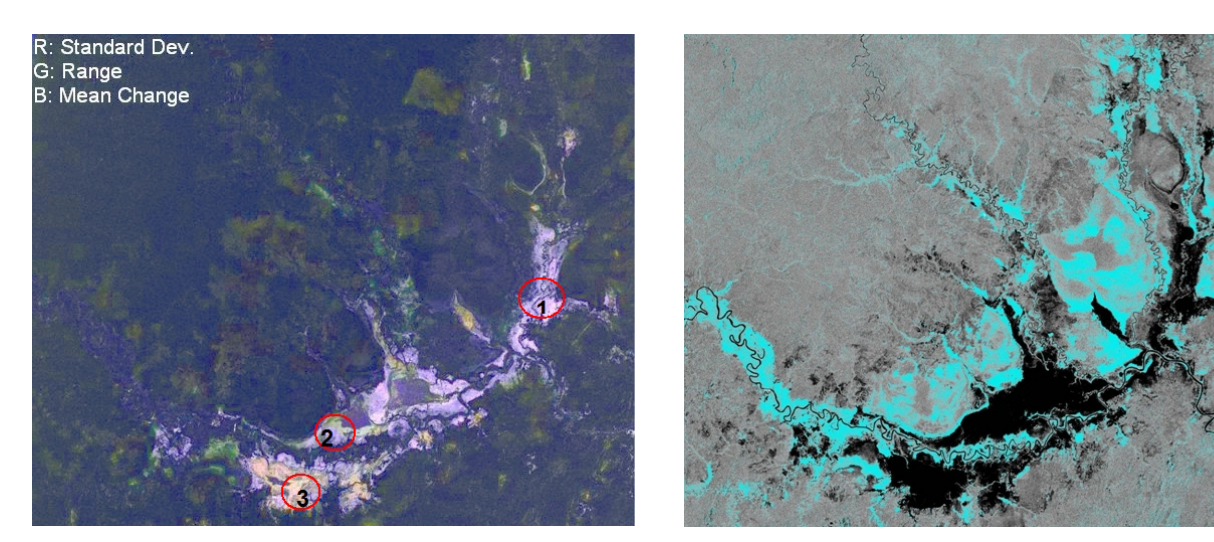
Fig. 8. Inundation extent obtained by averaging three images in wet periods (4 May 2007, 22 December 2008, and 9 February 2010). Dark areas indicate open water inundation extent, cyan indicates flooding under